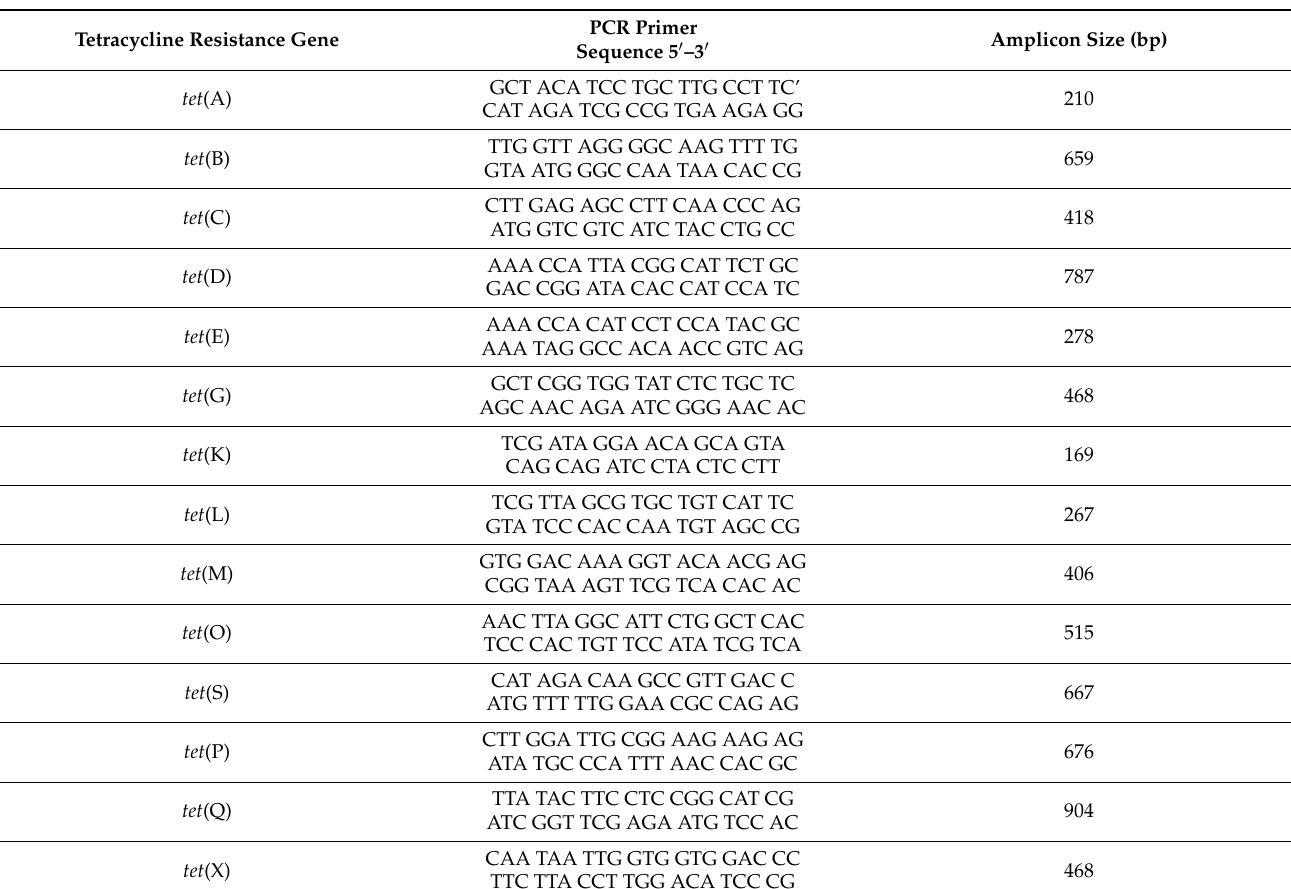
Table 1. Tetracycline-Resistant PCR Primers